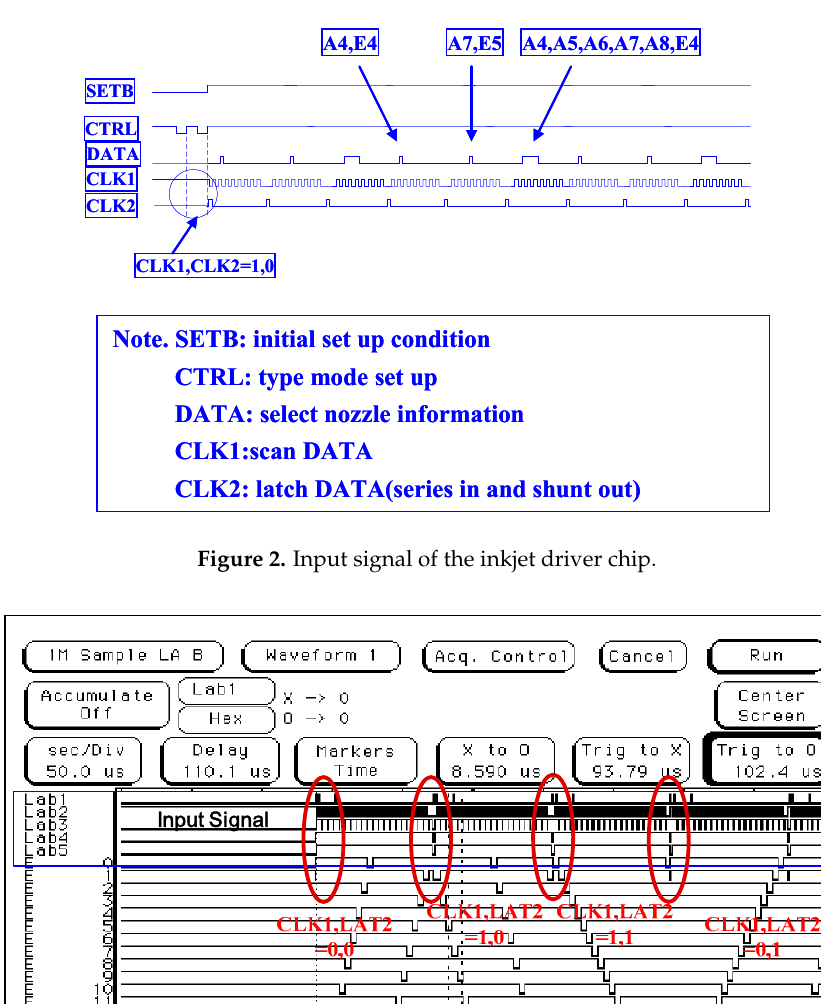
Figure 1. Multiplexer ink jet head of the uppermost layer within the inkjet driver wafer.